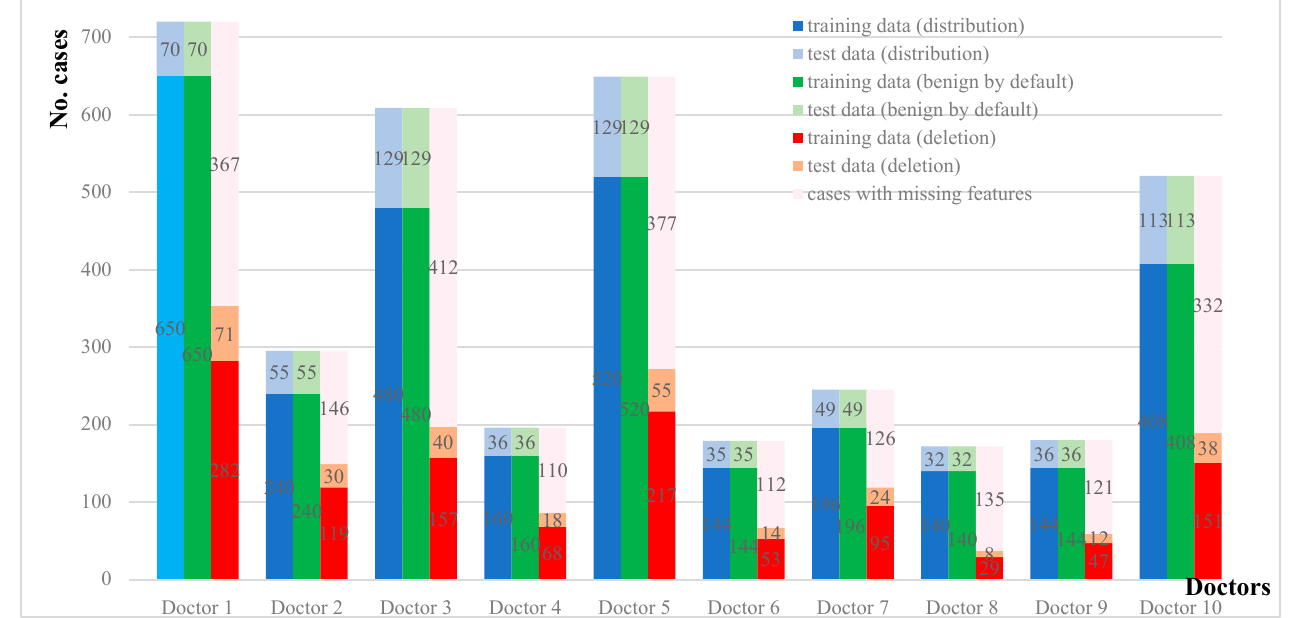
Figure 3. Training and test data under three assumptions of each doctor.